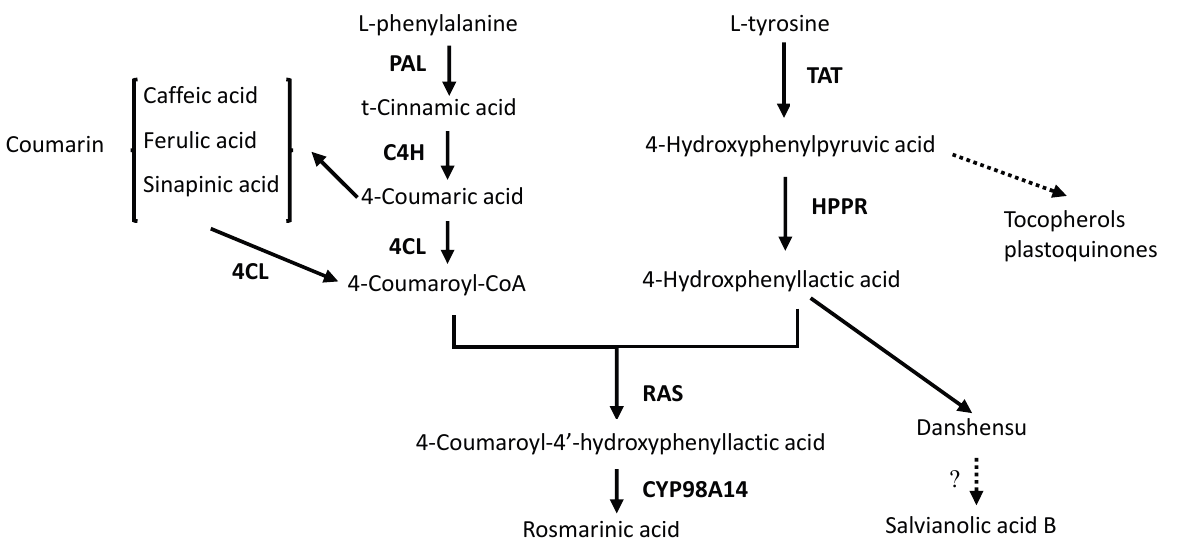
Figure 2. The metabolic pathways of rosmarinic acid and salvianolic acid B in S. miltiorrhiza hairy roots. Multiple enzymatic steps are represented by dotted lines. C4H, cinnamic acid 4-hydroxylase; 4CL, hydroxycinnamate coenzyme A ligase; HPPR, 4-hydroxyphenylpyruvate reductase; PAL, phenylalanine ammonia-lyase; RAS, rosmarinic acid synthase; TAT, tyrosine aminotransferase; CYP98A14, acytochrome P450-dependent